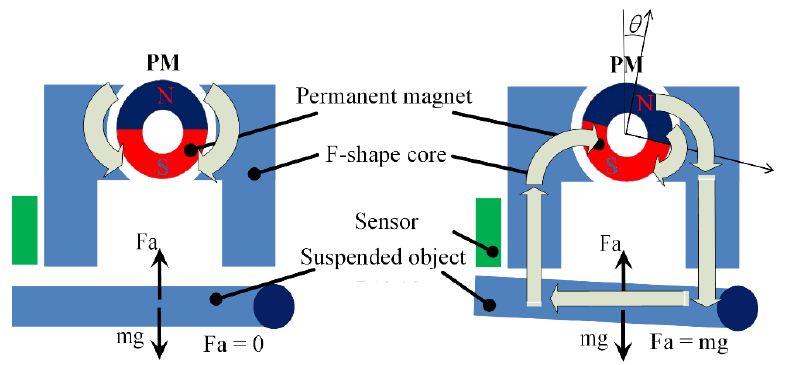
Figure 2. The initial state of the system ( left ) and the angle θ° of the magnet ( right ).